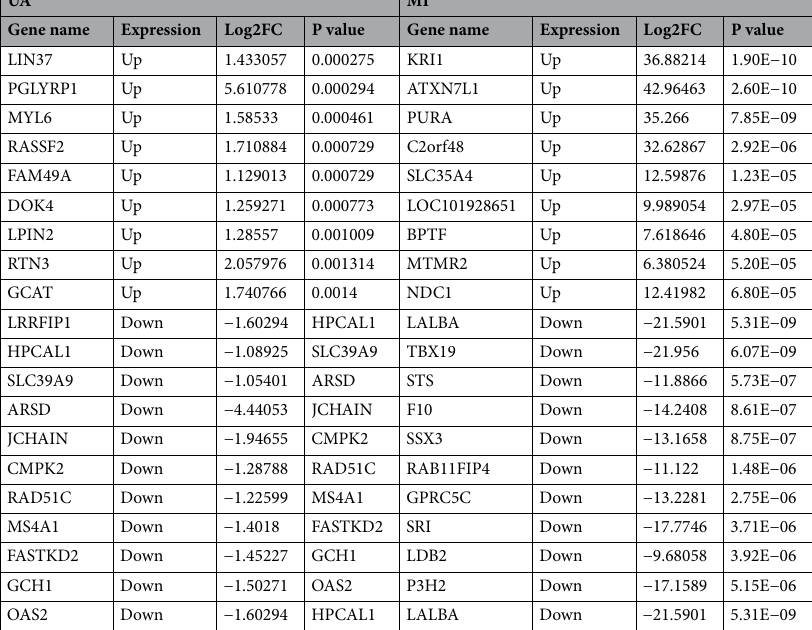
Table 1. Top 10 up-regulated and down-regulated DEGs. DEGs differentially expressed genes, Log2FC log2 fold-change, UA unstable angina, MI myocardial